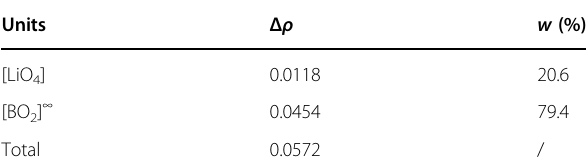
Table 1 Bonding electron difference ( Δ ρ ) of the bonds along the optical principal axes and contribution percent w (%) of the structural units that calculated by the response electron distribution anisotropy (REDA)